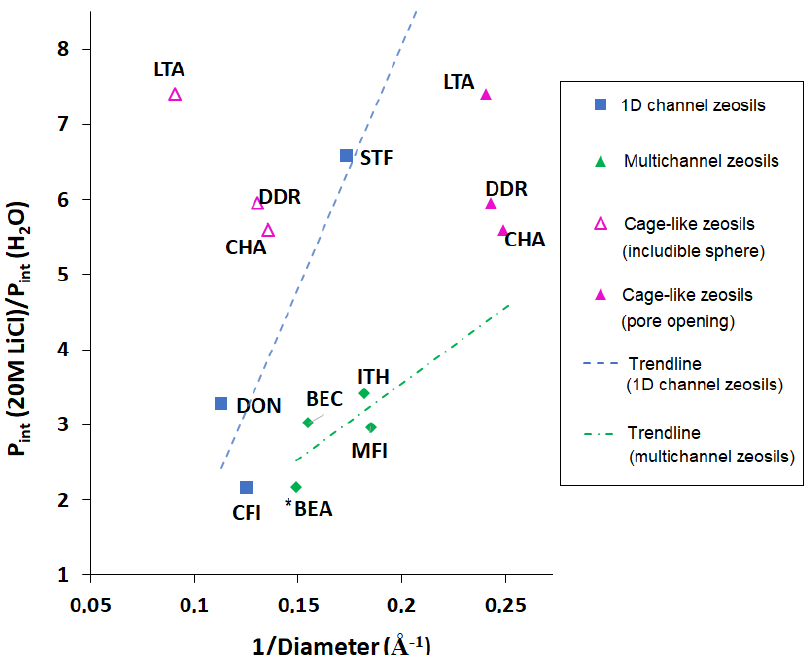
Figure 6. The relative increase of intrusion pressure of 20 M LiCl aqueous solution in comparison with water (P int (20M LiCl) / P int (H 2 O)) versus the inverse of the average diameter of the pore openings for channel-type zeosils and the diameter of pore openings and the maximal diameter of included sphere for cage-type ones.